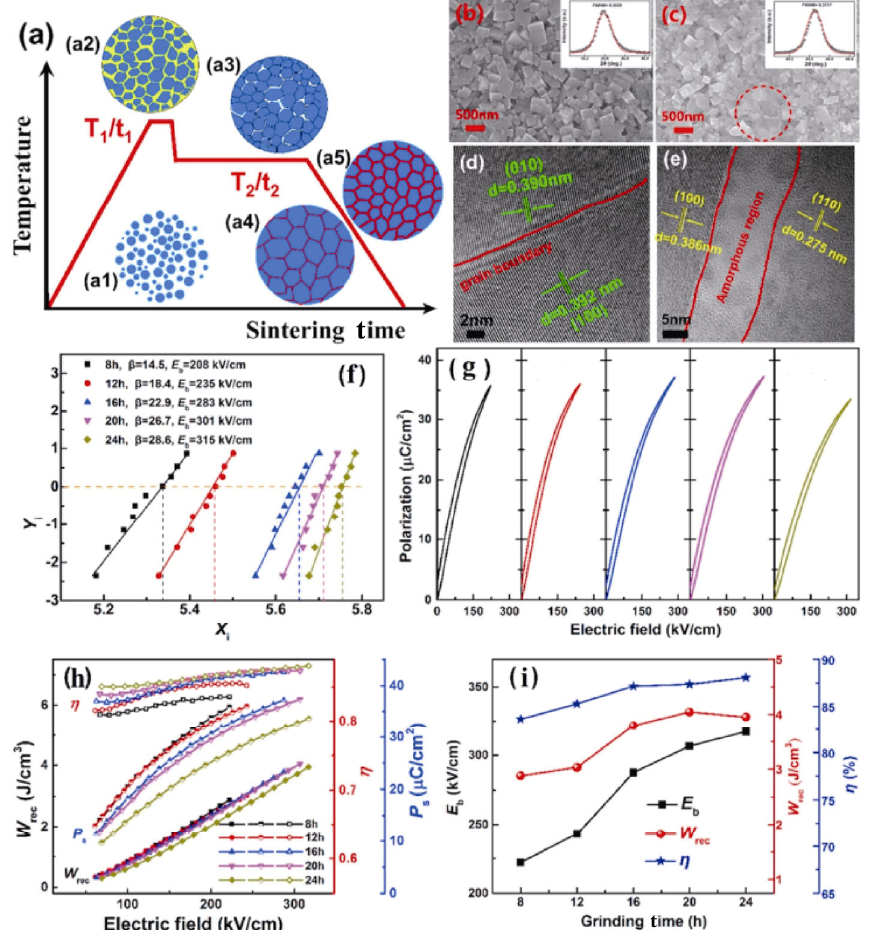
Fig. 9 (a) Schematic diagram of the two-step sintering method and corresponding ceramic morphologies. SEM and high- resolution TEM images of the ceramics after grinding for (b, d) 8 h and (c, e) 20 h. (f) Weibull distribution, (g) P – E loops, and (h, i) energy-storage properties at room temperature for the 0.975KNN–0.075BZTN ceramic with various grinding durations. Reproduced with permission from Ref. [53], © The Chinese Ceramic Society